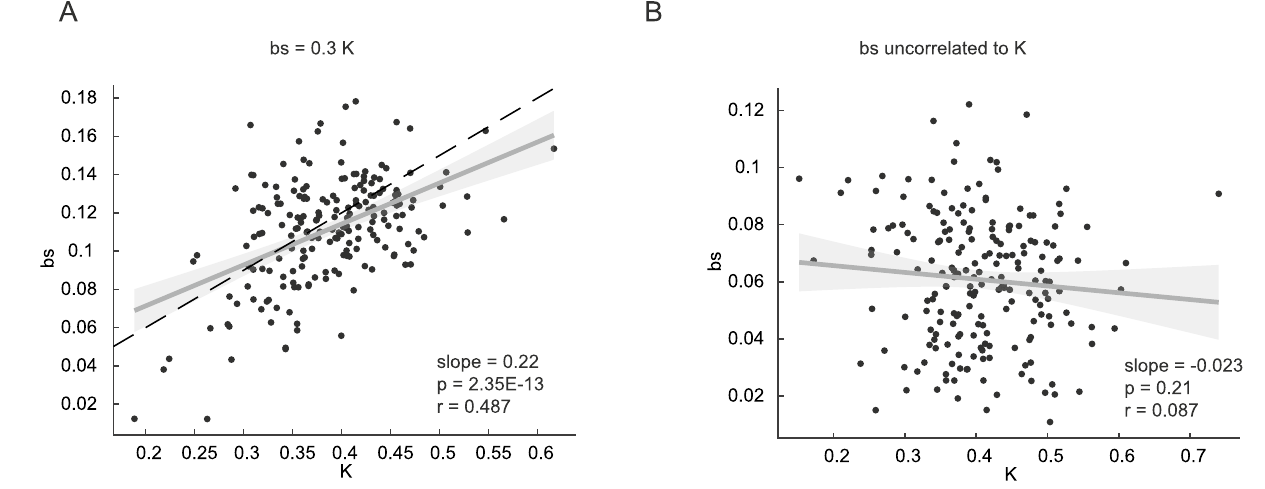
Figure 6. Recovery of simulated correlations between model parameters by the HMC algorithm. ( A ) A correlation among bs and K was introduced in the surrogate data by setting bs equal to 0.3 times K (dashed black line). ( B ) When no correlation between bs and K was added to the surrogate data, the HMC fitting algorithm did not introduce artificial spurious